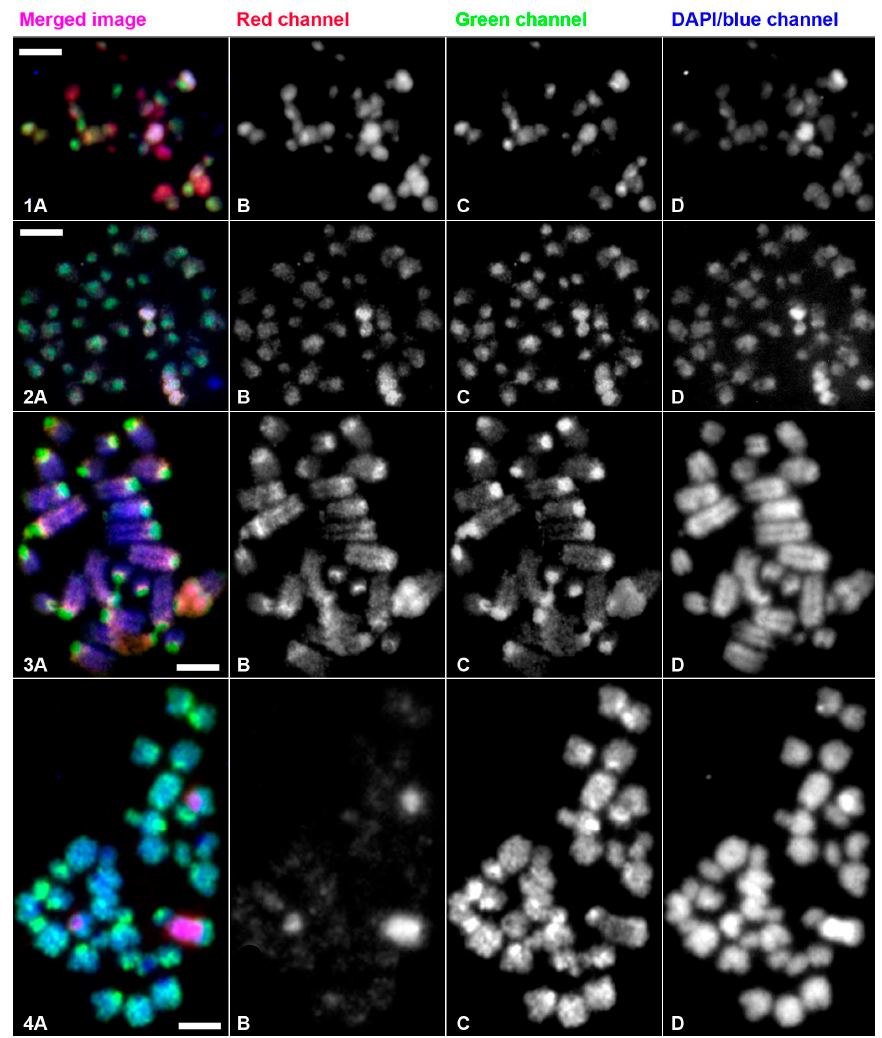
Figure 5. Results of inter- and intra-species comparative genomic hybridization (CGH) experiments: ( 1 ) chromosomes Almodovar: red Almodovar, green Rivalazzetto; ( 2 ) reciprocal experiment to the previous one. Chromosomes of E. virens Rivalazzetto (Italy), asexual female: red Almodovar (Spain), asexual female, green Rivalazzetto. Note a contamination with microorganisms, presumably microsporidia, in the right corner of the DAPI/blue channel ( 2A and 2D ); ( 3 ) chromosomes of E. virens Valencia (Spain), asexual female: red Corfu (Greece), sexual female, green Sidi Chiker (Morocco), sexual female. Note the higher red signal intensity in three putative rDNA bearing chromosomes in ( 3A – 3B ) and the higher green signal intensity in chromosome centromeres in ( 3A and 3C ); ( 4 ) chromosomes B. fuscata, Gauting (Germany) asexual female ( A ): red E. virens (Spain, Bull Pond, sexual female, ( B ), green DNA of B. fuscata , ( C ) DAPI-counterstained chromosomes of B. fuscata ; Scale bars indicate 3 µm.